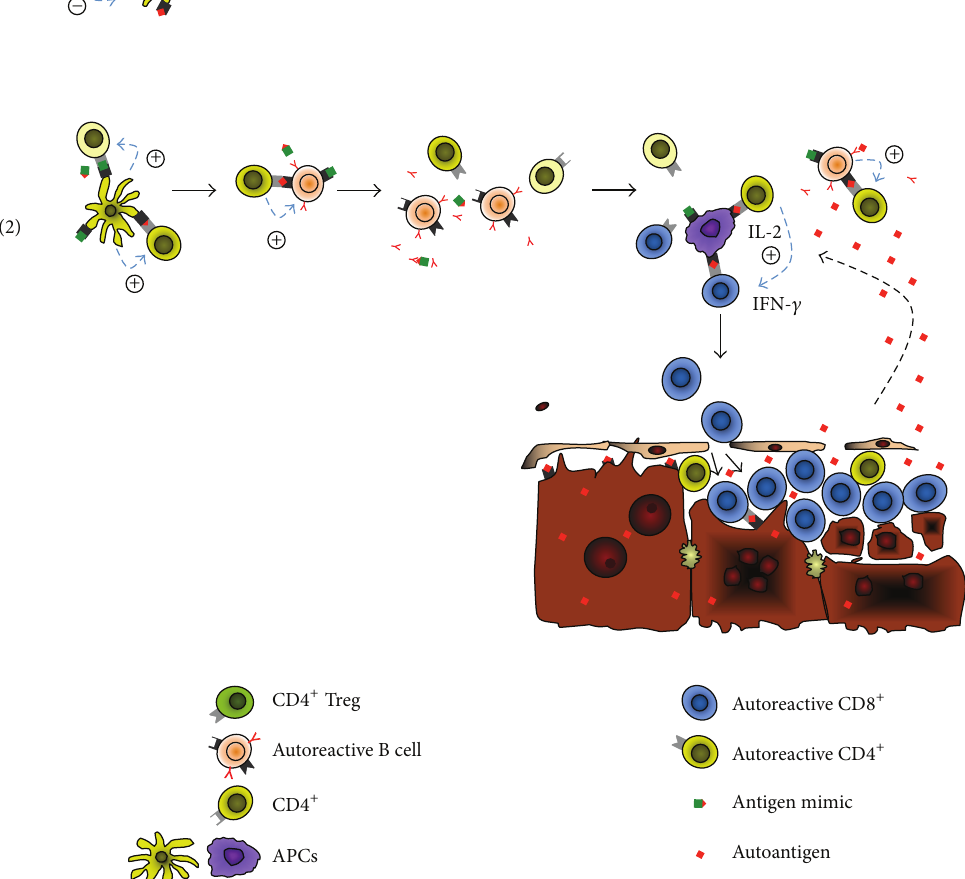
Figure 1: Role of CD4 + Tregs in the pathogenesis of autoimmune hepatitis. Based on data from experimental models and clinical observation we propose the following sequence of events leading to AIH through molecular mimicry. When an efficient peripheral tolerance to liver- expressed autoantigens (red) is induced either by preexisting natural Tregs or through the peripheral conversion of na¨ıve CD4 + T cells to CD4 + Tregs (green), activation of autoreactive CD4 + T cells (yellow) would be abrogated and development of AIH prevented (1). However, when CD4 + Tregs are present in small numbers, activation through molecular mimicry of autoreactive CD4 + T cells against an antigen mimic (red/green) could occur leading to the activation of autoreactive B cells (pink) and production of autoantibodies (2). Autoreactive CD4 + T cells could then go on to induce an autoreactive CD8 + cytotoxic T cell response (blue) to liver-expressed autoantigens leading to hepatocyte lysis, release of autoantigens (red), and perpetuation of the T and B cell autoimmune response to the